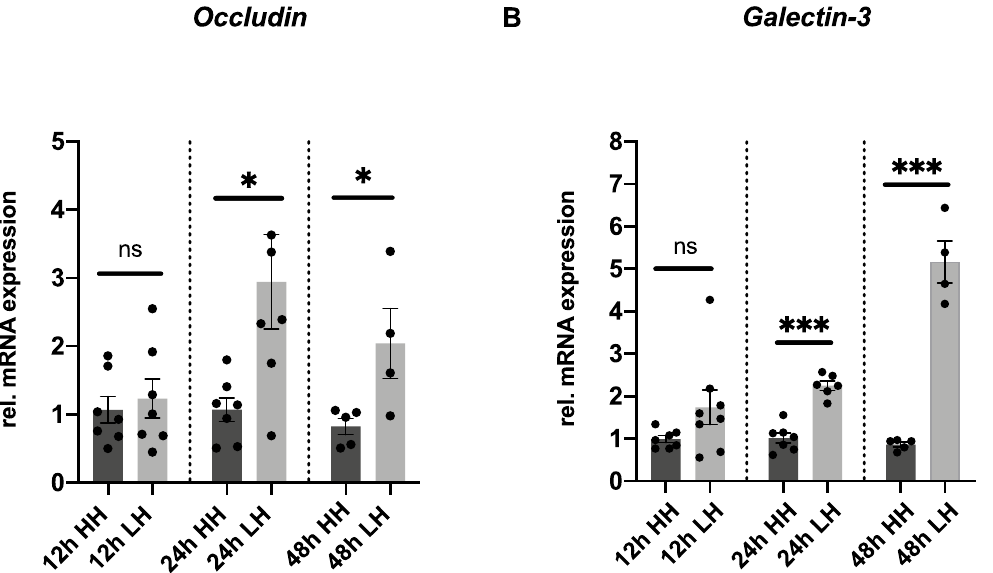
Figure 3. LH stimulates mRNA upregulation of tight junction and glycocalyx markers. ( A ) Occludin mRNA expression was 2.94-fold ( ± 0.69; p = 0.02) upregulated in porcine corneas incubated at LH for 24 h and 2.56-fold ( ± 0.64; p = 0.04) upregulated at the 48 h LH group. No difference in occludin expression was identified in porcine corneas incubated at LH for 12 h (1.23 ± 0.29; p = 0.65) in comparison to the 12 h HH controls. ( B ) Galectin-3 mRNA expression was 2.25-fold ( ± 0.11; p < 0.001) upregulated in corneas incubated at LH for 24 h and 5.16-fold ( ± 0.49; p < 0.001) upregulated in the ones cultivated at LH for 48 h. No difference in galectin-3 expression was verified in porcine corneas incubated at LH for 12 h (1.74 ± 0.41; p = 0.12) in comparison to the 12 h HH controls. n = 8 for 12 h LH/ n = 7 for 12 h HH/ n = 6–7 for 24 h LH/ n = 7 for 24 h HH/ n = 4 for 48 h LH/ n = 5 for 48 h HH. LH: low humidity. HH: high humidity. The bars represent the mean values, and the SEM is shown. * p ˂ 0.05 *** p ˂ 0.001. ns: not